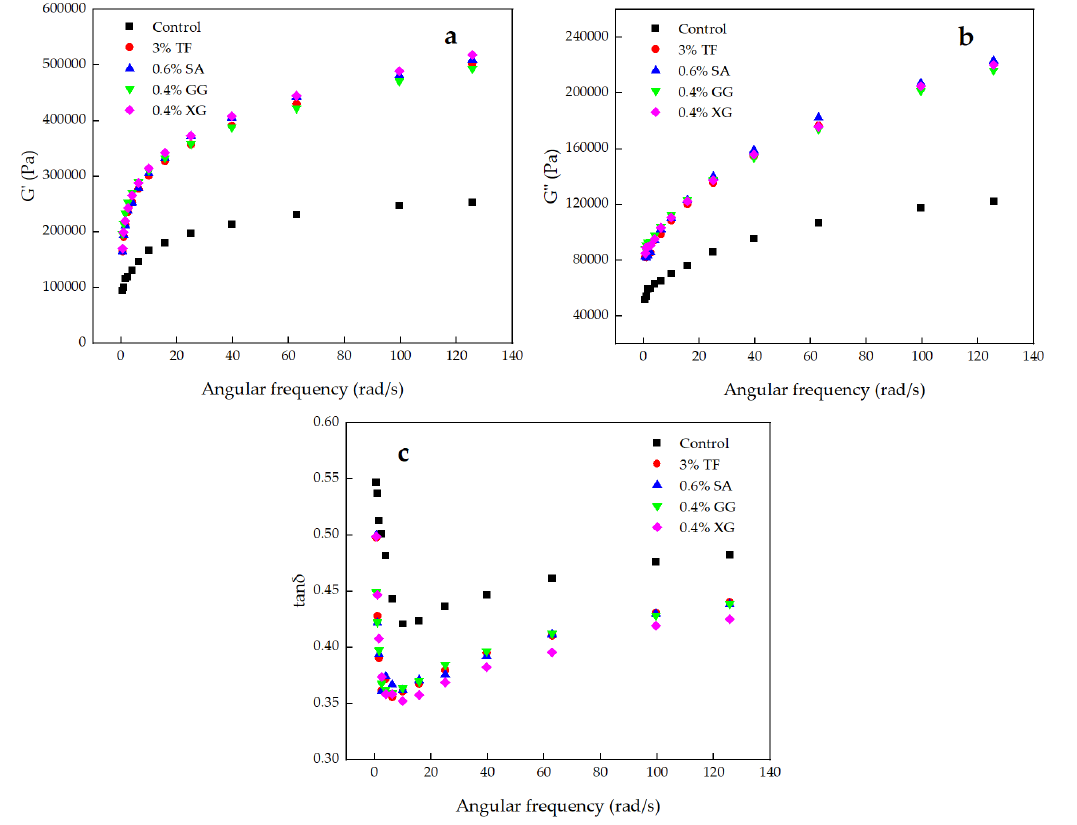
Figure 3. Effect of TF, SA, GG and XG on the ( a ) storage modulus (G ′ ), ( b ) loss modulus (G ″ ), and ( c ) loss tangent (tan δ ) of dough.